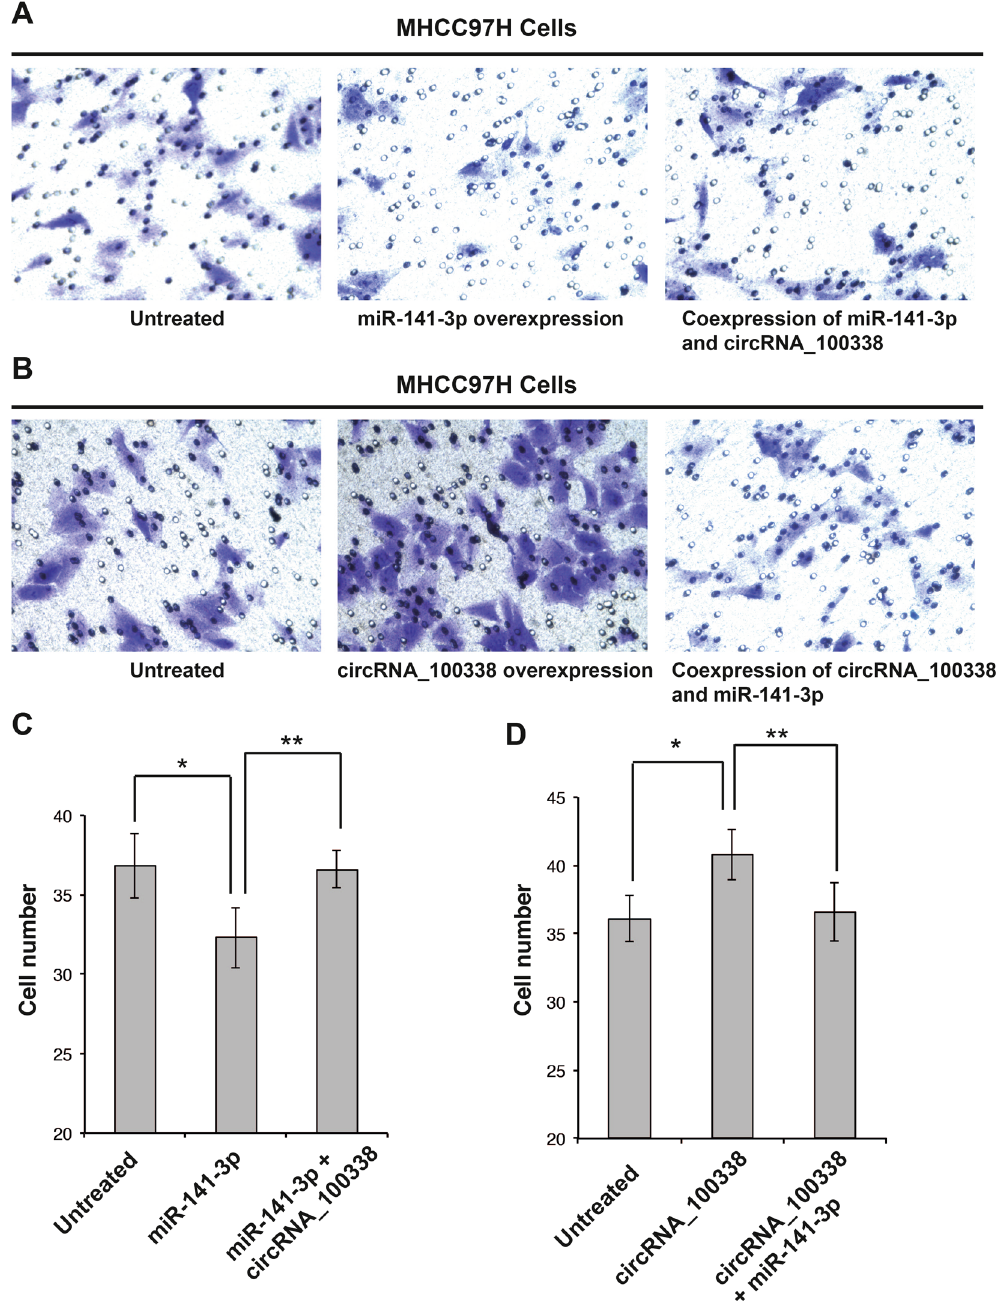
Figure 5. circRNA_100338 and miR-141-3p regulate the metastatic potential of liver cancer cells. ( A ) In vitro invasion assay in MHCC97H cells overexpressing miR-141-3p or co-expressing both miR-141-3p and circRNA_100338. ( B ) In vitro invasion assay in MHCC97H cells overexpressing circRNA_100338 or co- expressing both circRNA_100338 and miR-141-3p. ( C ) The number of invasive cells in assays of MHCC97H cells overexpressing miR-141-3p. Data are presented as the means ± SE of three assays. n = 3; * P = 0.013; ** P = 0.004. ( D ) The number of invasive cells in assays with MHCC97H cells overexpressing circRNA_100338. Data are presented as the means ± SE of three assays. n = 3; * P = 0.005; ** P =